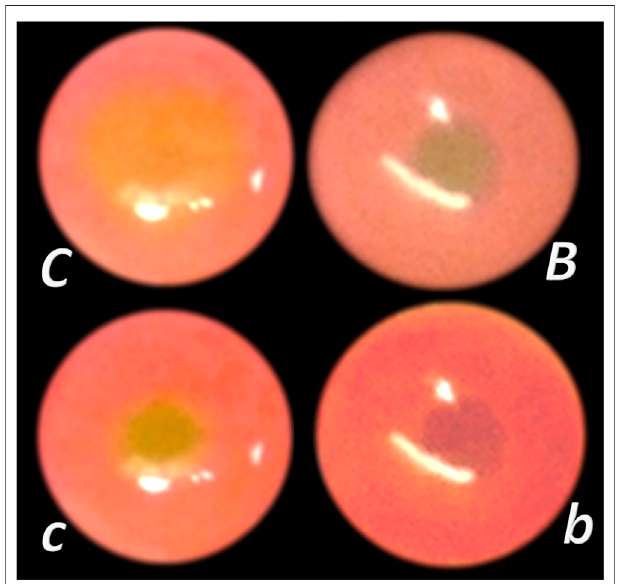
FIGURE 15 | Total debridement of corneal epithelium and BPC 157 therapy(Lazicetal.,2005).Totaldebridementofcornealepitheliumpreformed in rats unilaterally and lesions stained (green) and photographed. Medication was distilled water (control group) or BPC 157 2 pg/ml, 2 ng/ml, and 2 μ g/ml,twodrops/rat eyestartedimmediatelyafterinjuryinduction,every8 h up to 40 h (i.e., at 0, 8, 16, 24, 32, and 40 h). Lesions presentation at 24 h in controls ( C ) and lesions attenuation in BPC 157 rats ( B ), lesions presentation at 32 h in controls ( C ) and lesions disappearance in BPC 157 rats ( B